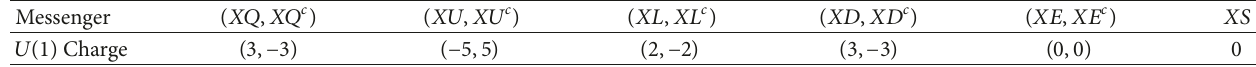
Table 2: Complete list of messenger fields and their 𝑈(1) charge